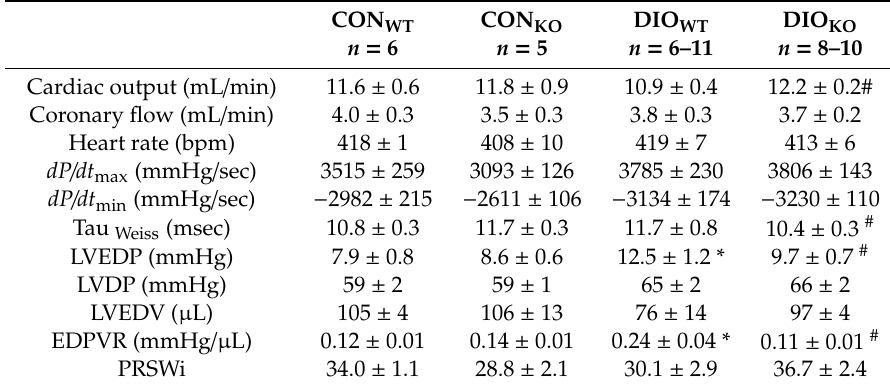
Table 3. Steady state and load-independent parameters of left-ventricular (LV) function obtained in isolated perfused working hearts from wild type (WT) and global NOX2 knock out (KO) control mice (CON) and diet-induced obese mice (DIO) given an obesogenic diet for 28 weeks.